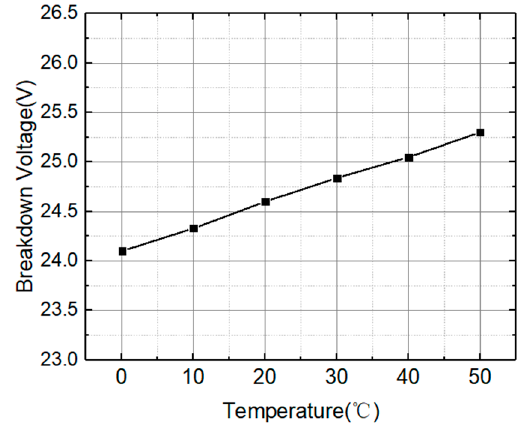
Figure 13. Breakdown voltage measured for various temperatures.